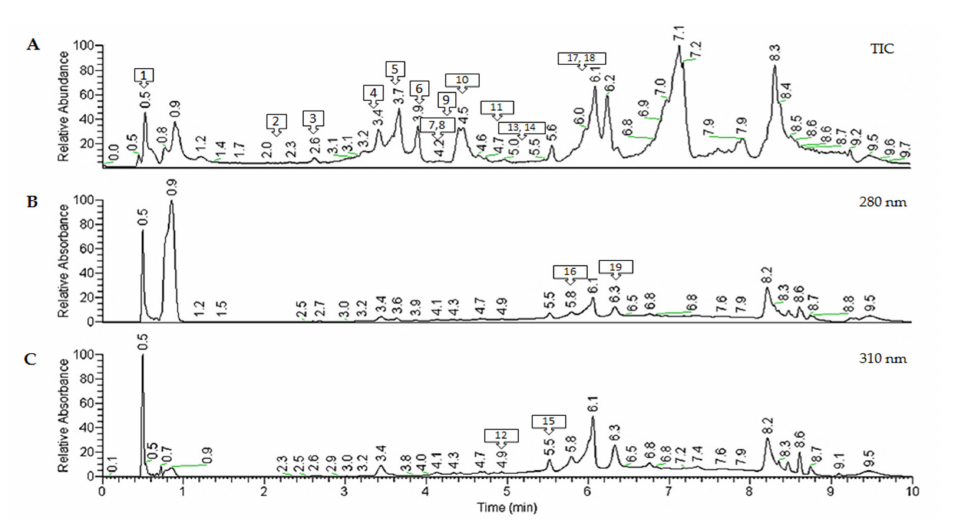
Figure 2. Spectra obtained for a representative A. borbonica acetone-evaporated extract. ( A ) Representative total ion chromatogram (TIC) obtained in negative mode. ( B ) UHPLC-UV chromatograms obtained at 280 and 310 nm ( C ). The di ff erent molecules are numbered according to their retention